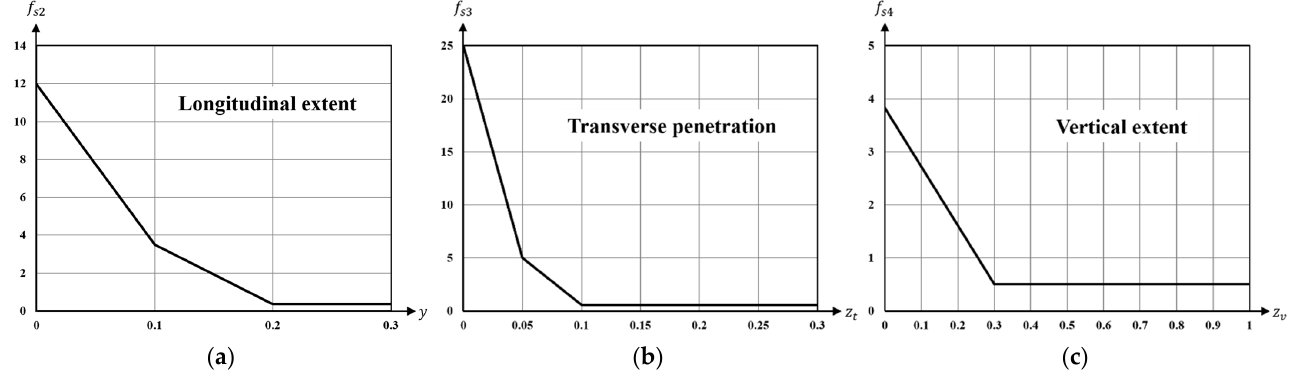
Figure 6. Side damage due to collision: ( a ) density distribution functions of longitudinal extent, ( b ) density distribution functions of transverse penetration, and ( c ) density distribution functions of vertical extent.